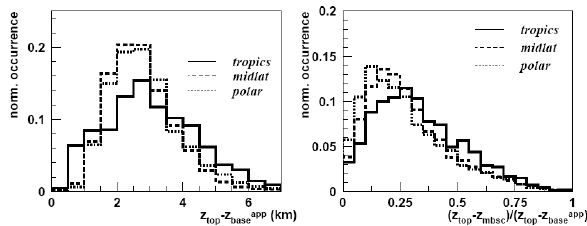
Figure 11: Normalized frequency distributions of ‘apparent’ cloud geometrical thickness (left) and of the relative height of the maximum backscatter signal compared to the ‘apparent’ cloud geometrical thickness (right) for high opaque clouds, separately for three different latitude bands: 30°N-30°S (full line), 30°-60° (broken line) and 60°-90° (dotted line).